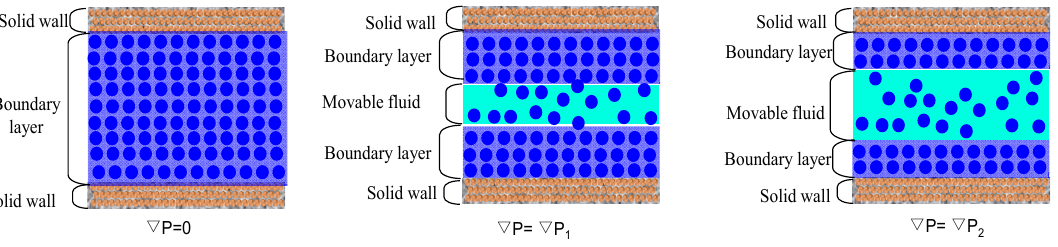
Figure 4. Schematic diagram of boundary layer thickness versus displacement pressure gradient ( ∇ P 1 < ∇ P 2 ).